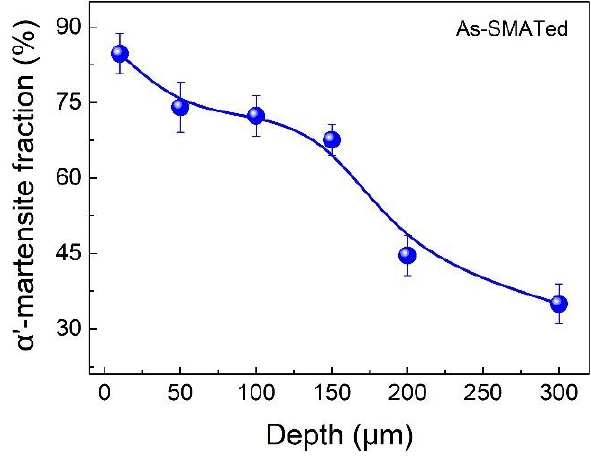
Figure 3. Variation of α’-martensite volume fraction along the depth.